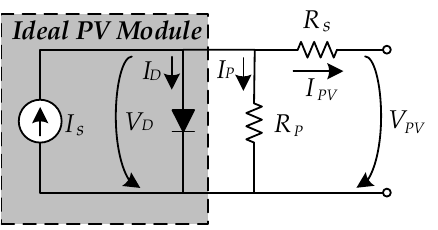
Figure 5. Electric equivalent circuit of an SPV module using the single diode model.